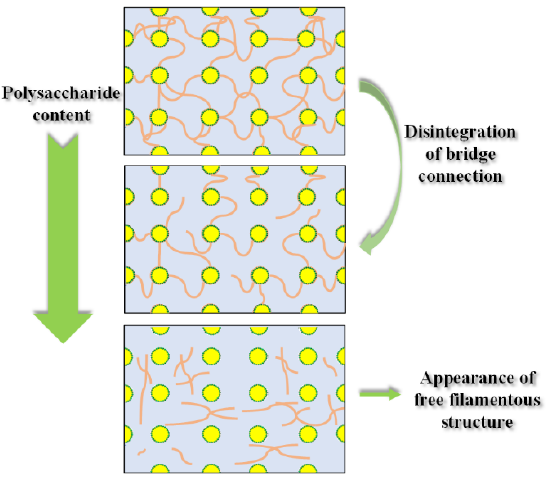
Figure 7. Schematic diagram of structural change of the continuous phase of emulsion with the decrease of polysaccharide content.